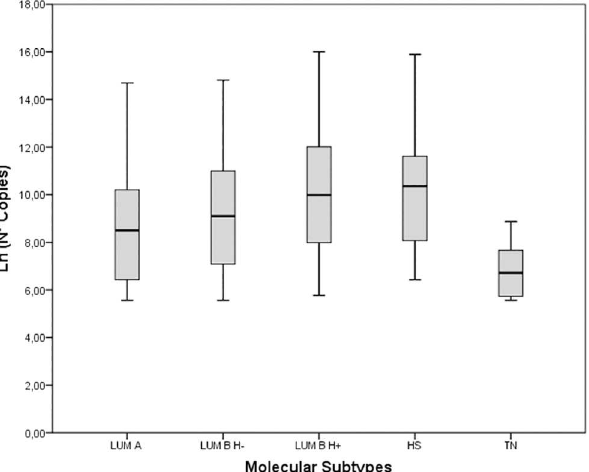
Fig 2. Cytokeratin19 mRNA copy number distribution according to molecular subtypes. Box Plot showingthe distribution of cytokeratin 19 mRNA copy number in the five molecularsubtypes. The Kruskall- Wallis test indicatesa significantdifference amonggroups (p < 0.0001). Data are expressedon a log scale for presentation purposes.